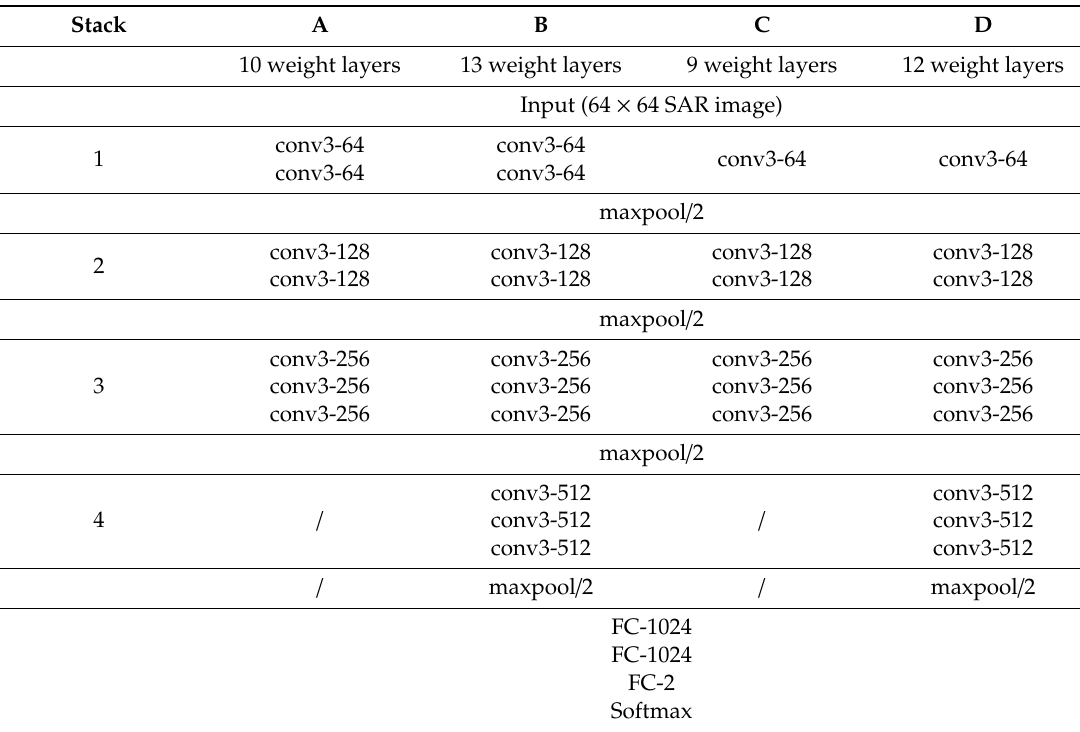
Table 3. Network structures of the four